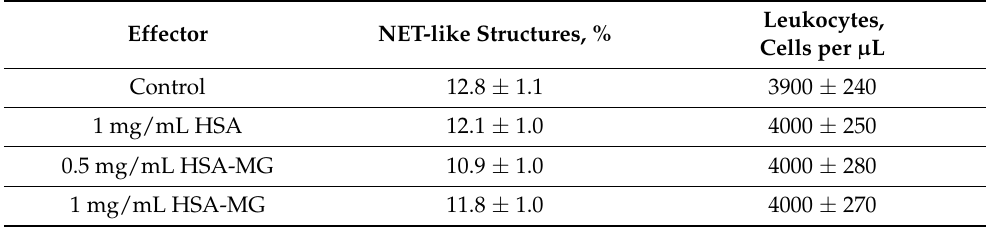
Table 3. Effects of HSA and HSA-MG on leukocyte count and NET-like structure percentage in whole blood after 3 h incubation followed by addition of 100 nM